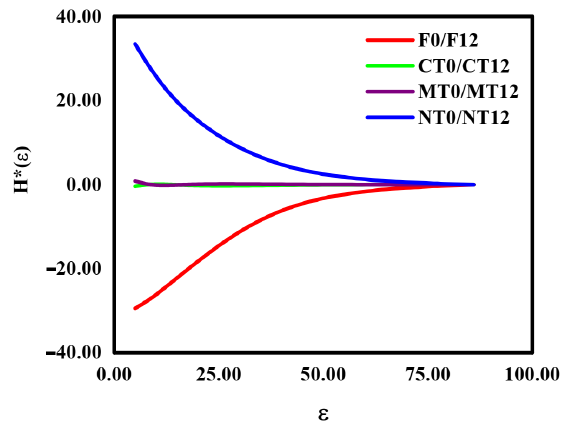
Figure 5. Variation of the 3D normalized Shannon’s entropy (H*( ε )) of the samples submitted to 0 and 12 wetting and drying (W-D) cycles. Secondary forest—F; conventional tillage—CT; minimum tillage—MT; no tillage—NT. ε is the box size.